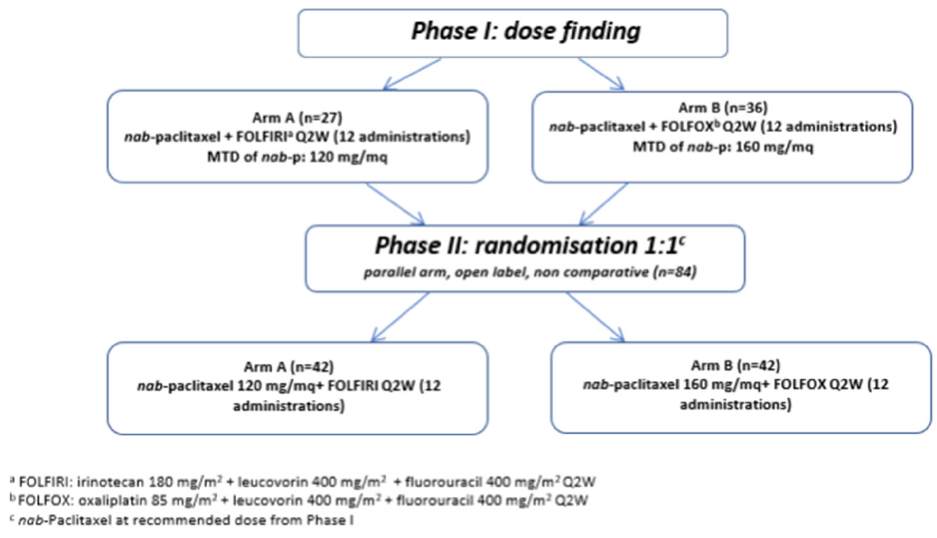
Figure 1. Flow chart of NabucCO study design.